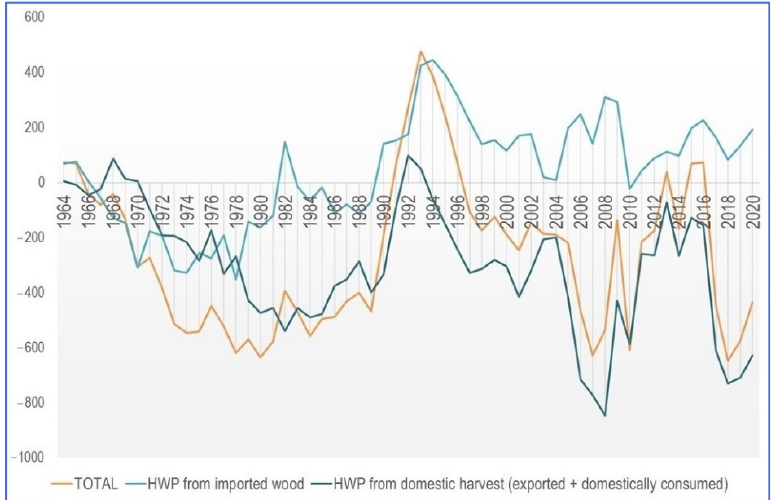
Figure 8. Emissions and removals from the HWP pool in time period of 1964–2020 (kt CO 2 ). The predicted annual net removals from the HWP pool decrease from the historic value of − 436 kt CO 2 in 2020 to the − 39 kt CO 2 value predicted for 2070. This indicates that assuming a constant inflow equal to the average inflow of the last five historic years leads to a decreasing trend in the CO 2 removals. In the 2070s, the predicted removals are already very close to zero (Figure 9).